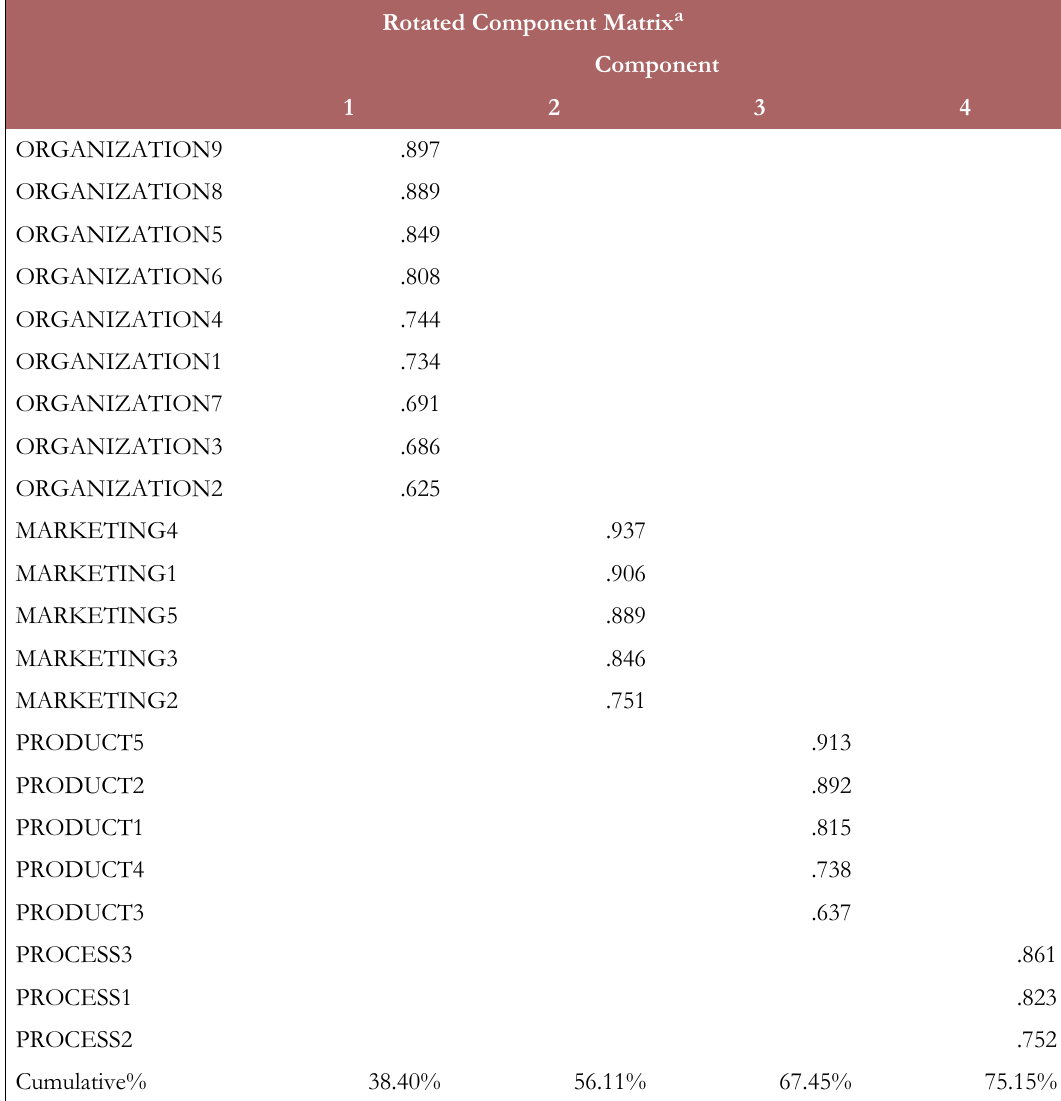
Table 2. Exploratory factor analysis for innovation